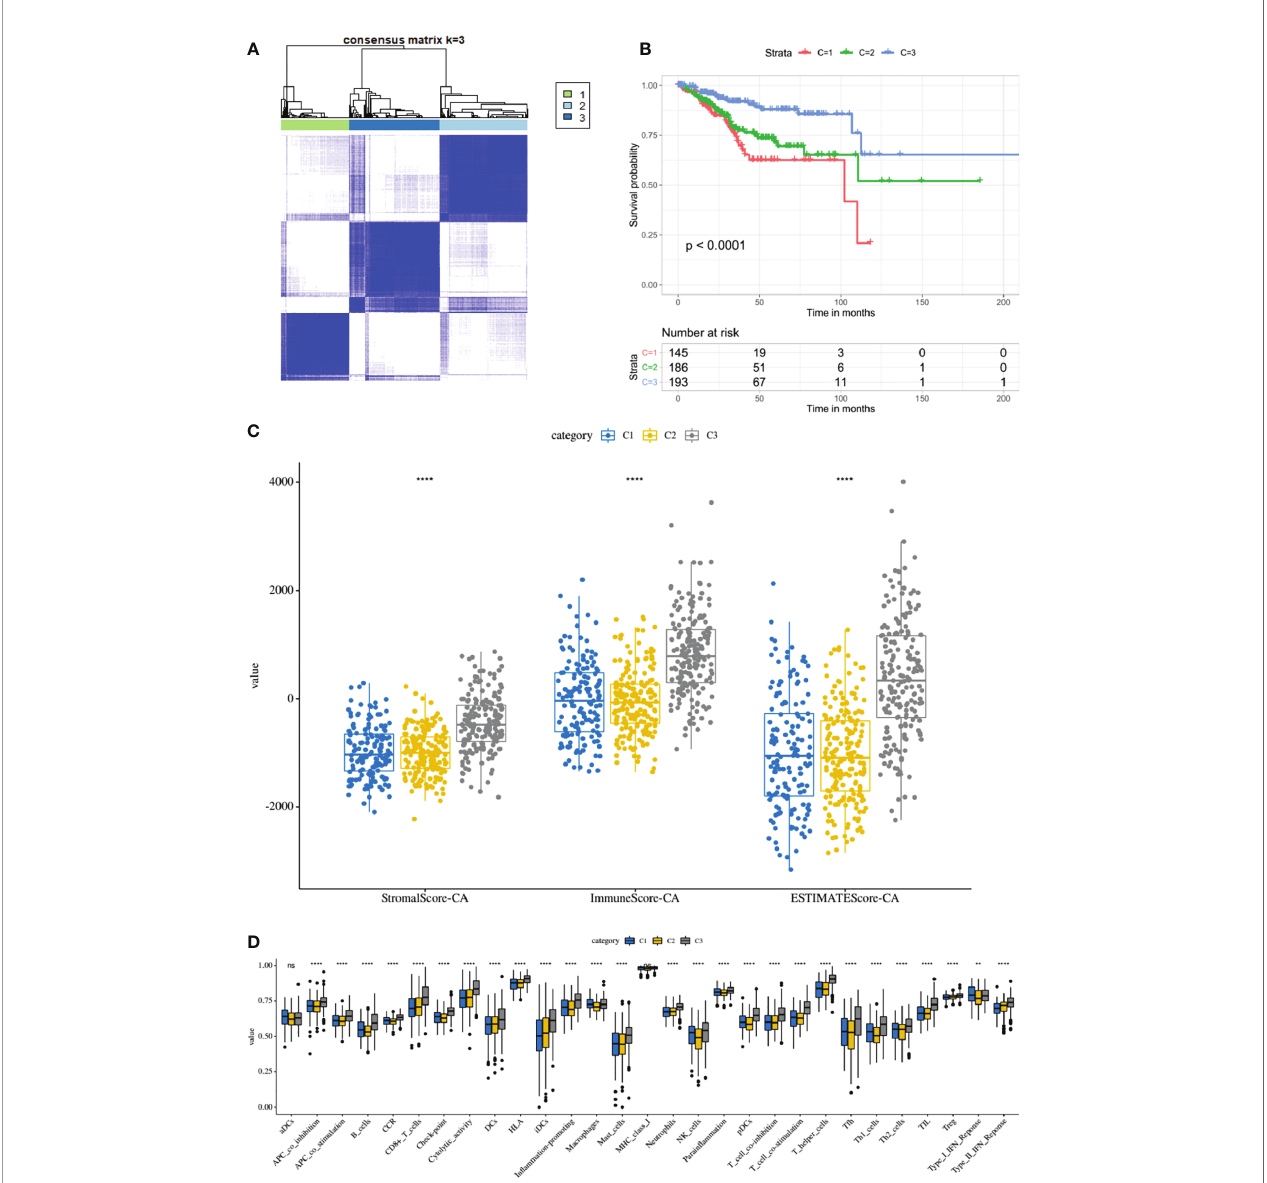
FIGURE 7 | The immune microenvironment was closely related to the prognosis of EC patients. (A) TCGA EC cohort was clustered into three subgroups by unsupervised cluster analysis. (B) K-M survival curves of three clusters. (C) The comparison of stromal scores, immune scores, and ESTIMATE scores between three clusters. (D) Box plots for comparison of immune cell in fi ltration between three clusters. ****, P < 0.0001; NS, not signi fi